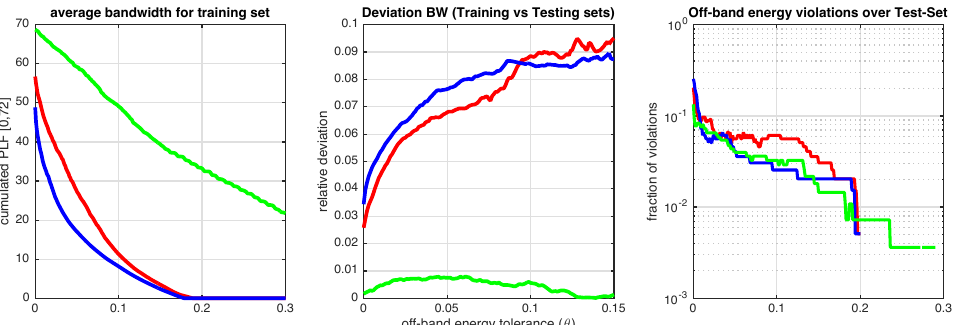
Figure 11. Average width of bands found for the training set as θ changes while λ is fixed in 1 [leftmost], relative deviation between average widths register for training and testing sets [middle], and violations of off-band energy limits over testing set. [red samples correspond to Garrad Hassan, blue ones to Meteológica and green to